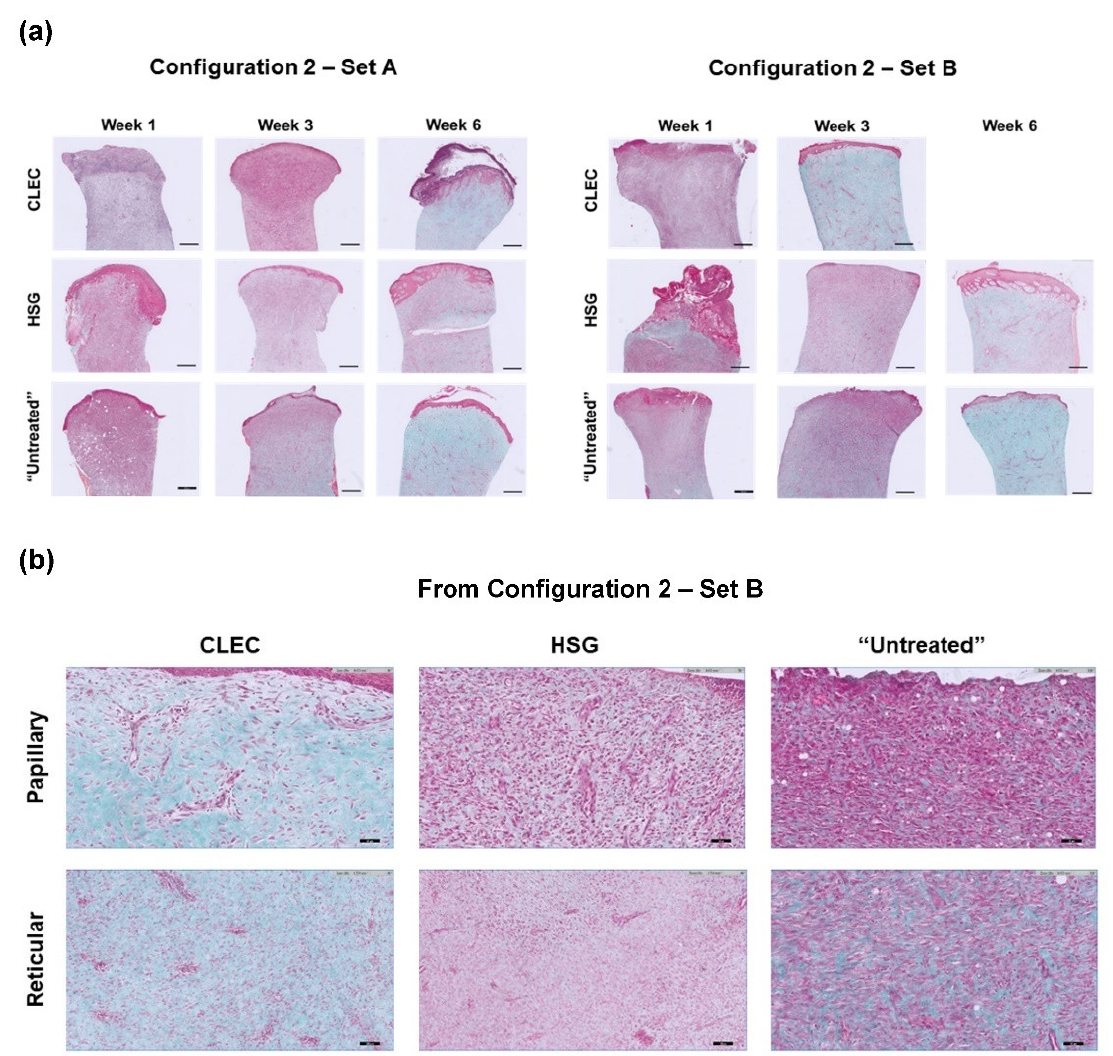
Figure 5. Week 3 tissue biopsies of pig cutaneous wounds treated with CLECs (CLEC), human skin grafts (HSG), and standard dressings (“Untreated”) probed with Masson’s Trichome (MT) stain ( a ) at 2 × magnification for three time points in Configuration 2 Sets A and B with scale bar = 500 µ m; ( b ) at 20× magnification based on Configuration 2 Set B with scale bar = 50 µm. Table 2. Semi-quantitative scoring of Masson’s Trichome (MT) stains at the papillary and recticular dermis of skin tissue biopsies shown in Figure 5a.